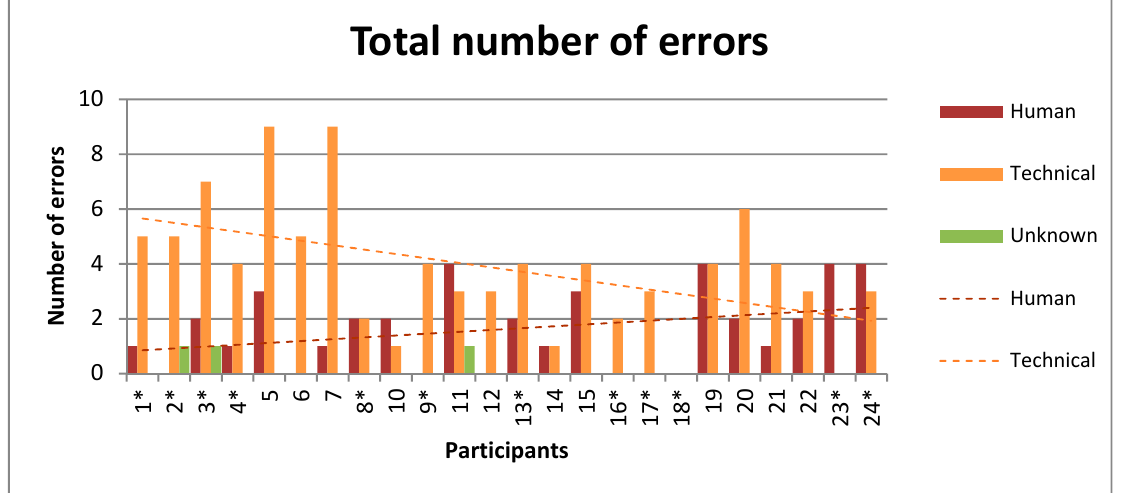
Figure 3. Number of technical, human interaction, and unknown errors for each participant. Participants are ordered chronologically based on inclusion date. Incomplete Spinal Cord Injury (iSCI) patients are marked with an asterisk (*), others are stroke patients. Linear regression lines based on errors over time have a significant negative correlation (R 2 = 0.24) for technical errors and non-significant positive correlation (R 2 = 0.11) for human interaction errors.